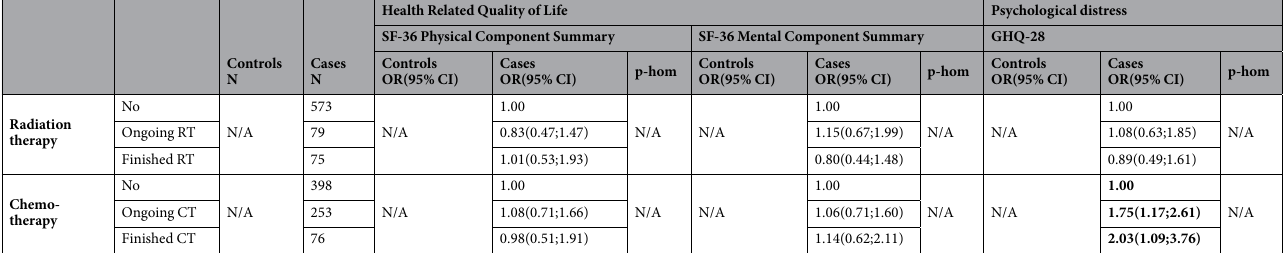
Table 2. Association of sociodemographic, lifestyle, and clinical factors with low scores a in the SF-36 component summaries and with psychological distress. a Low score: scores ≤ 45 points, i.e. five or more points under the reference population mean, fixed at 50 points. ORs and 95% confidence intervals derived from multivariable logistic regression models, adjusted by all the variables in the table and by region of residence. Data in bold represent statistically significant associations. * Statistically significant trend. CT: Chemotherapy; HER2: Human epidermal growth factor receptor 2; HR: Hormone Receptor; N/A: Not applicable; RT: Radiation therapy; SDR: Second-degree relatives; p-hom: p homogeneity, estimated from the model including interaction terms between each factor and case/control